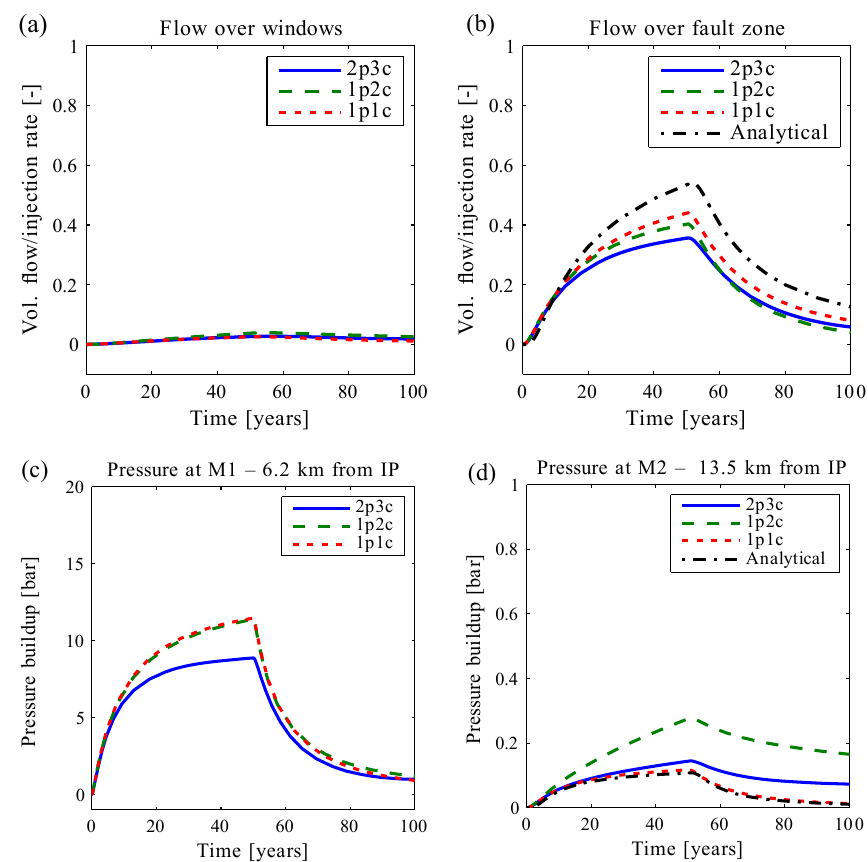
Figure 14. Focused leakage scenario: results for the focused leakage scenario (Upper Buntsandstein barrier permeability is 1 × 10 − 20 m 2 ). Top row: volumetric flow over the hydrogeological windows and the fault zone. Bottom row: pressure buildup at measurement points M1 and M2 in the injection horizon. Note that there are no results for the Analytical Model for panel (a) as the Analytical Model only accounts for flow over the fault zone. Additionally, only the pressure at the fault zone shown in panel (d) can be determined with the Analytical Model used